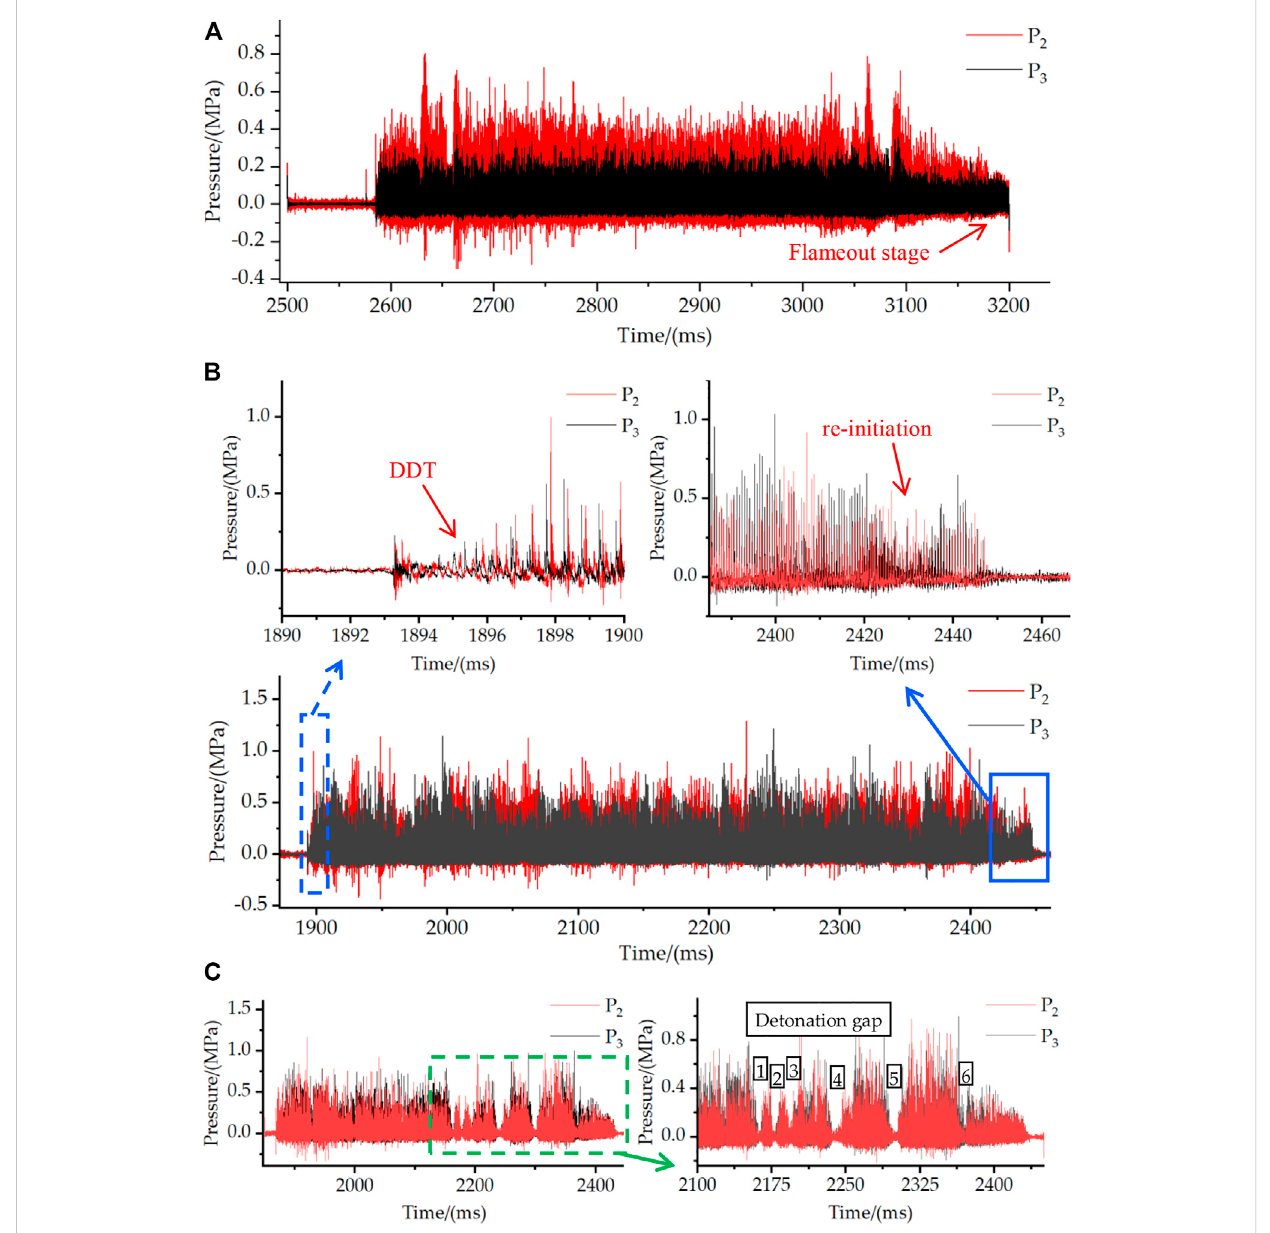
FIGURE 7 Results of operating at different widths of the air annular slot: (A) ER = 1.2 and l w = 3 mm; (B) ER = 1.2 and l w = 5 mm; (C) ER = 1.2 and l w = 6